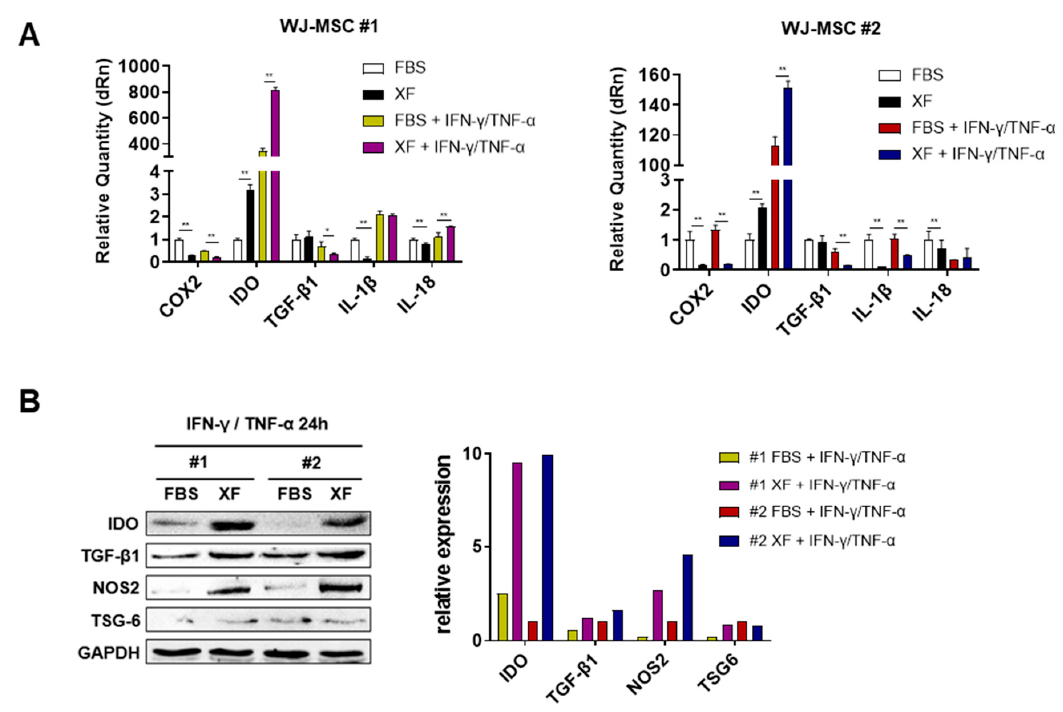
Figure 4. XF conditions enhance the expression of immunoregulatory factors in WJ-MSCs. WJ-MSCs were cultured in FBS and XF conditions were treated with or without IFN- γ (10 ng / mL) and TNF- α (10 ng / mL) for 24 h. ( A ) Gene expression of the immunoregulatory and inflammatory factors was determined by qRT-PCR (* p < 0.05, ** p < 0.01). ( B ) After IFN- γ and TNF- α treatment for 24 h, IDO, TGF- β 1, NOS2, and TSG-6 expression were measured by Western blot analysis. The results are representative of independent experiments performed at least three times.